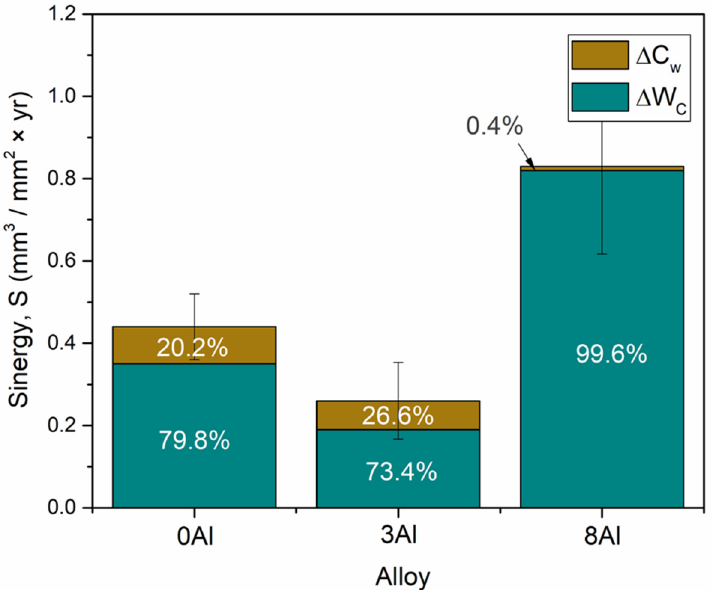
Figure 13. Contributions to the synergy of the change in wear rate due to corrosion, Δ W c , and of the change in corrosion rate due to mechanical wear, Δ C w .